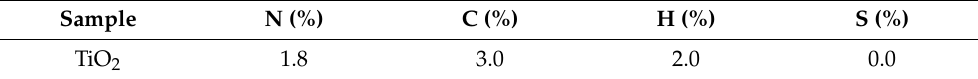
Table 1. Results of elemental analysis for modified titanium dioxide.